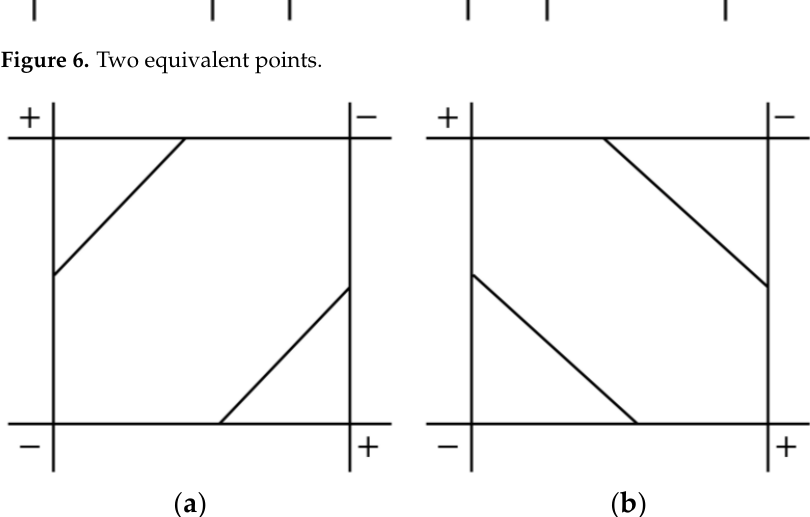
Figure 7. Four equivalent points. ( a , b ) are two possibilities, respectively .